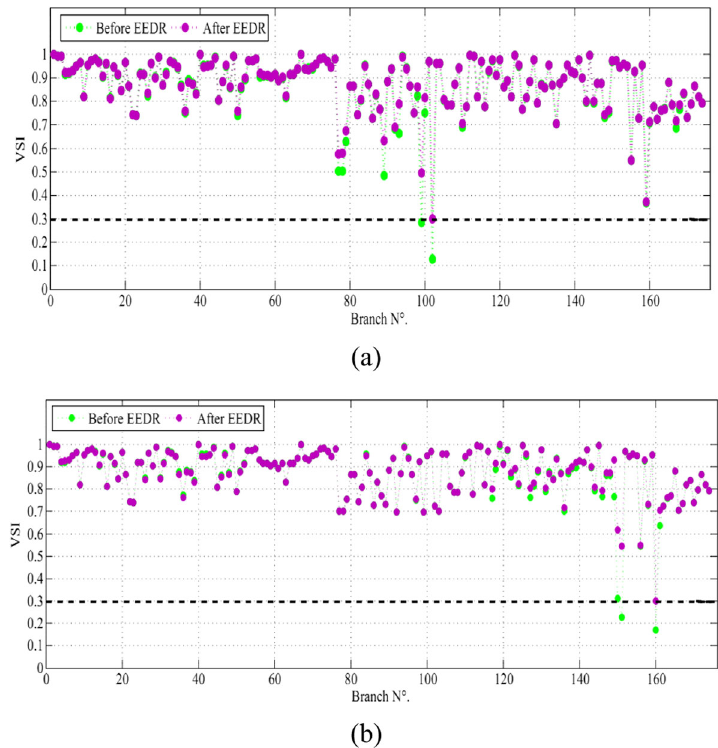
Fig. 13 VSI of the Algerian 114-bus system in the case of (a) loss of line (63 – 66), (b) loss of line (81 – 90)